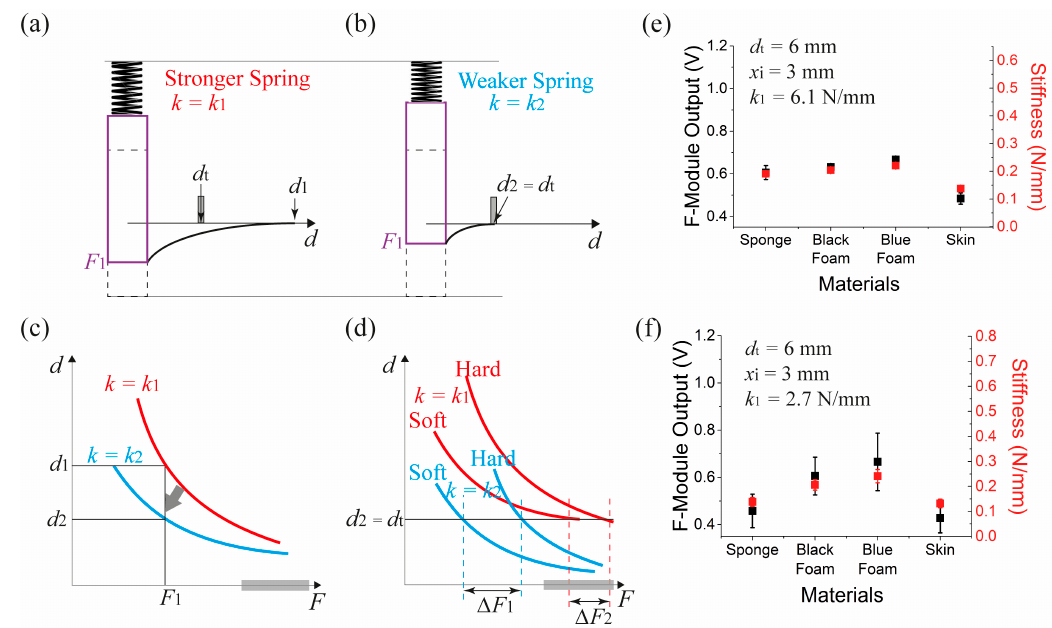
Figure 10. Spring constant dependent stiffness measurement. Illustration of the variation of IE for a stronger spring ( a ) and a weaker spring ( b ). ( c ) Distribution of the IE position depending on the spring constant. ( d ) Spring constant dependent force sensing range selection. Stiffness measurement obtained when the spring constant was ( e ) 6.1 N/mm and ( f ) 2.7 N/mm. For both cases, d t was 6 mm, and x i was 3 mm. (Note, ( f ) is the same as Figure 9f).